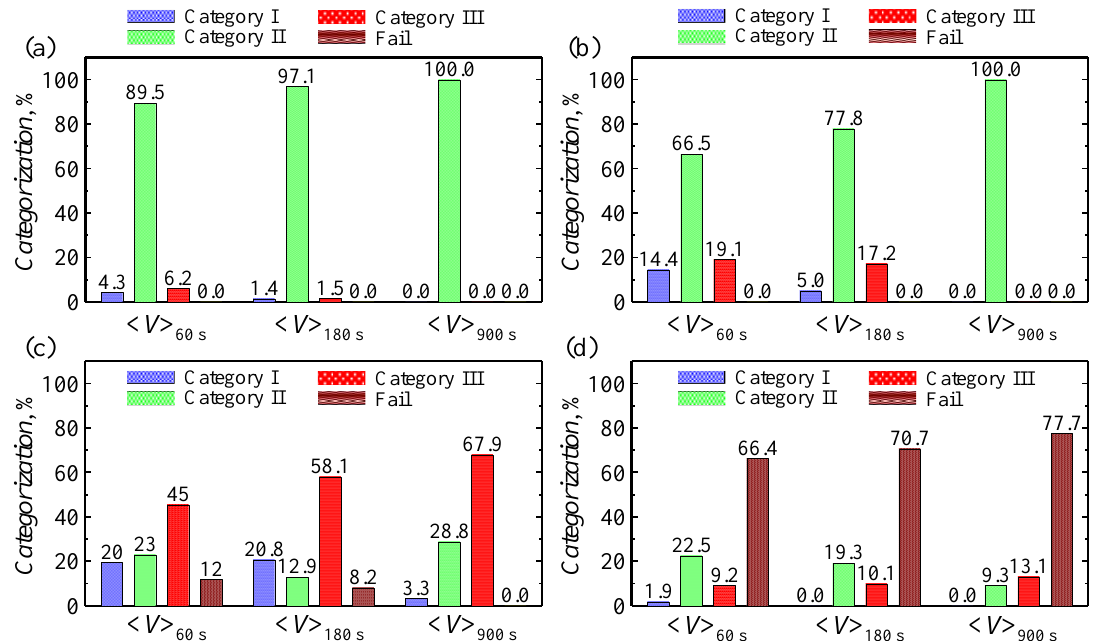
Figure 12. Categorization of the classroom environment, based on measured DR time variation: ( a ) z = 0.1 m, ( b ) z = 0.6 m, ( c ) z = 1.1 m, and ( d ) z = 1.7 m (data for θ = 25°, case #1).